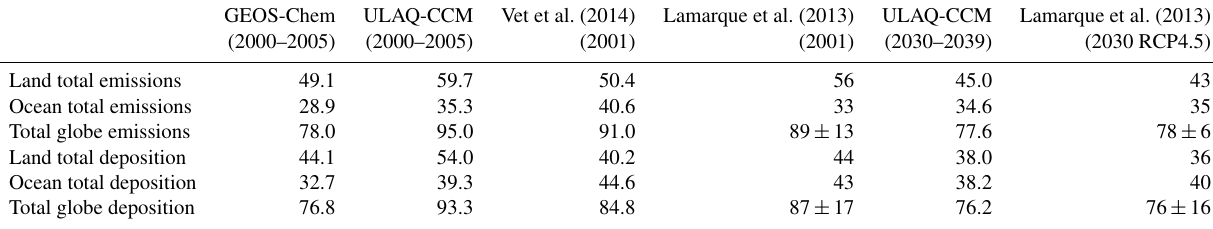
Table 2. Integrated sulfur emission and deposition fluxes for baseline conditions over land, ocean and the entire globe, for ULAQ-CCM and GEOS-Chem, compared to Vet et al. (2014) and Lamarque et al. (2013) values (TgSyr − 1 ).